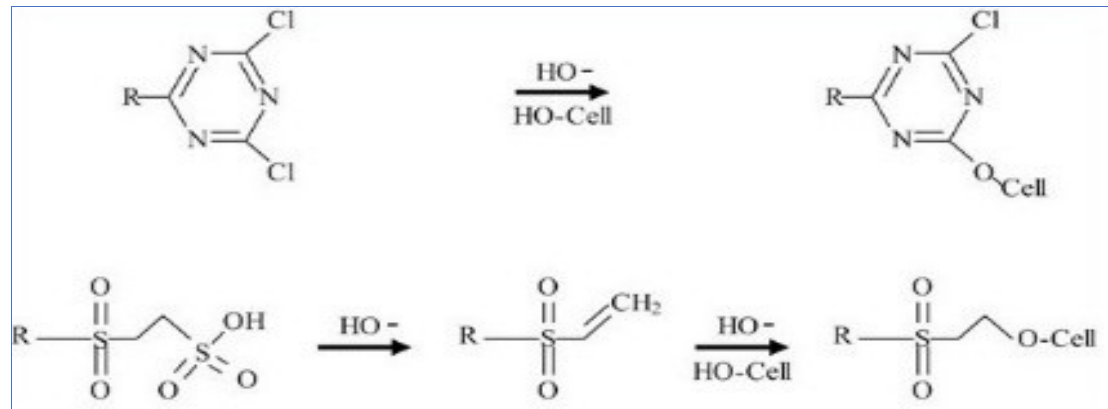
Figure 4. Reactive dyeing mechanism on cellulose.